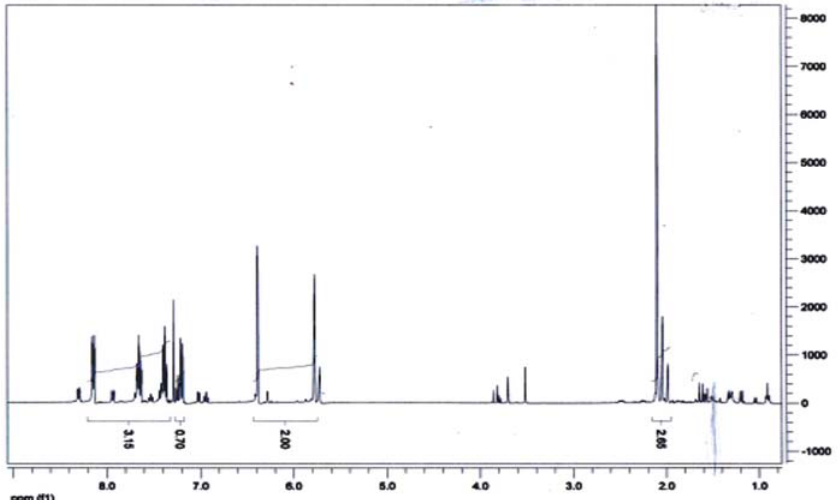
Figure 3. 1 H-NMR of 2-methacryloyloxybenzoic acid.